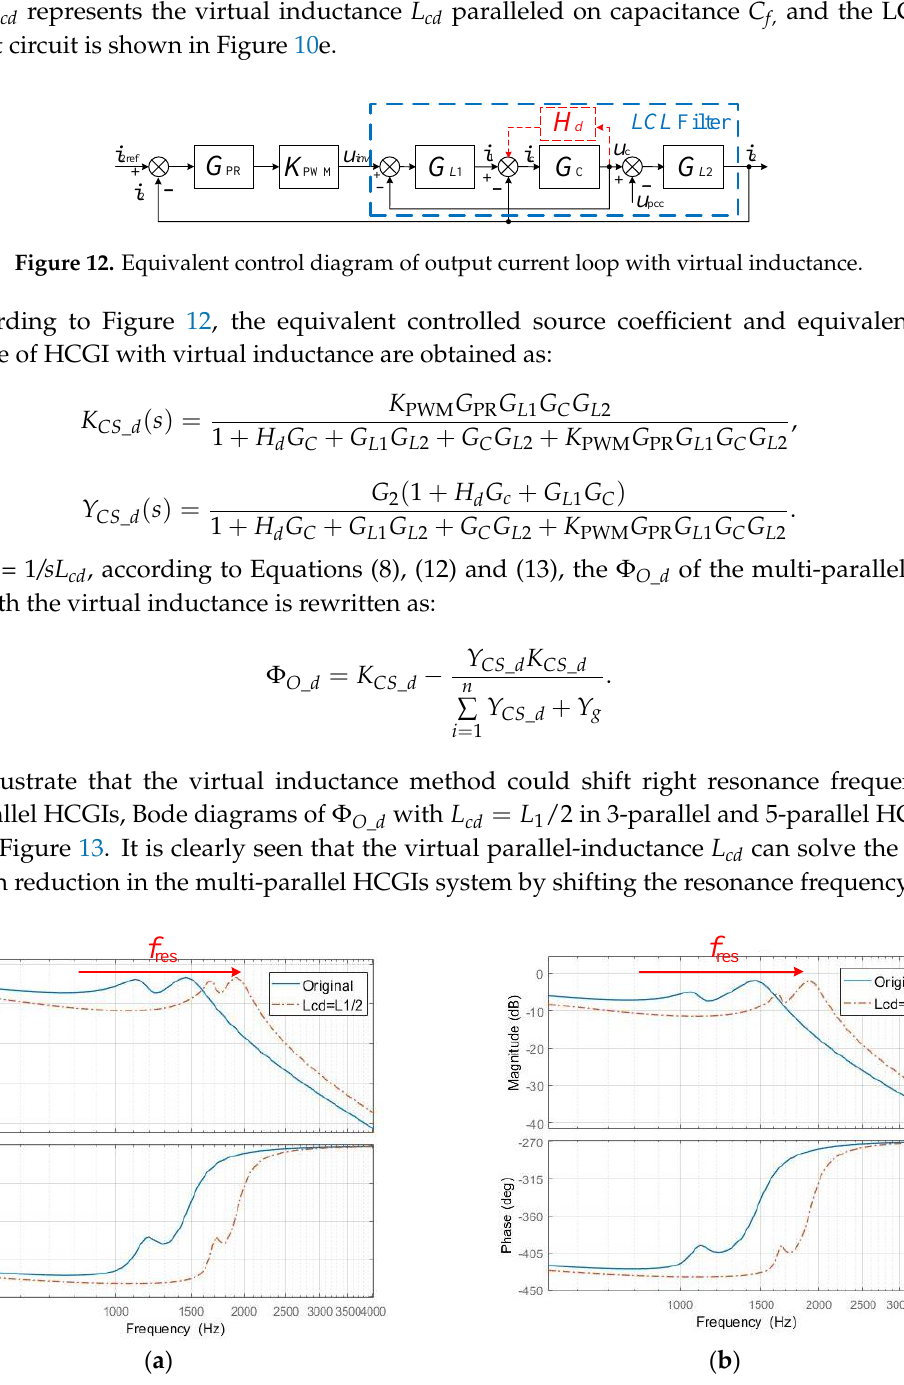
Figure 13. Bode diagram of multi-parallel HCGIs with L.